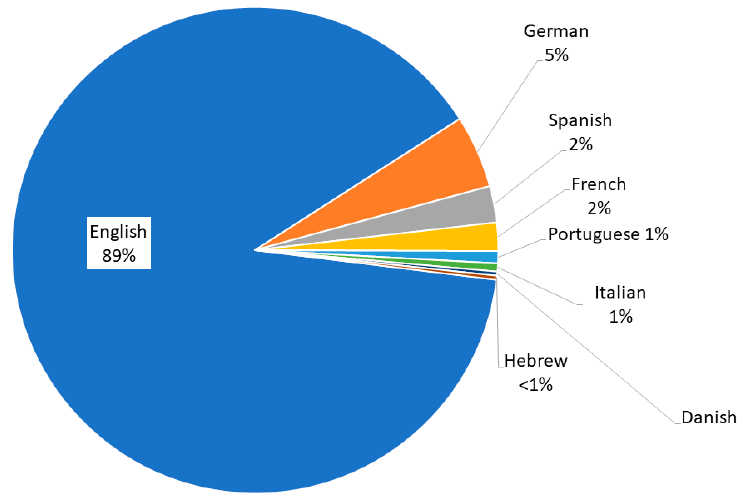
Figure 4. Languages of scientific production. Table 1. Main journals and their